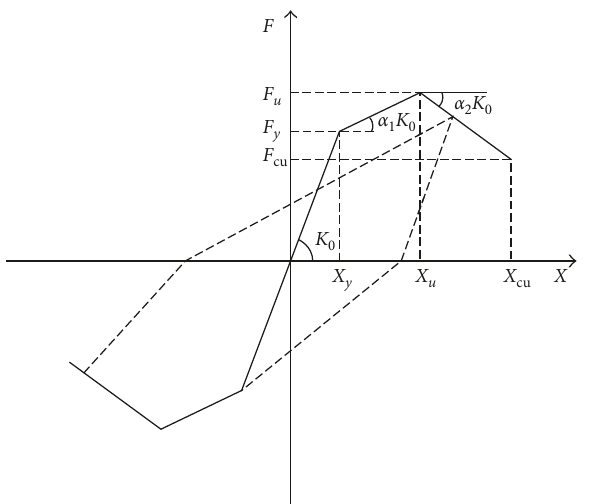
Figure 1: The force-restoring model of reinforcement concrete members with flexure and compression.